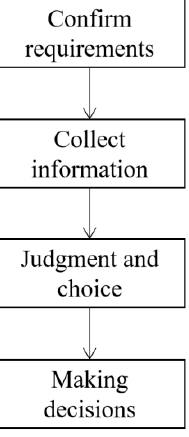
Figure 3. The decision-making process of IoT users.